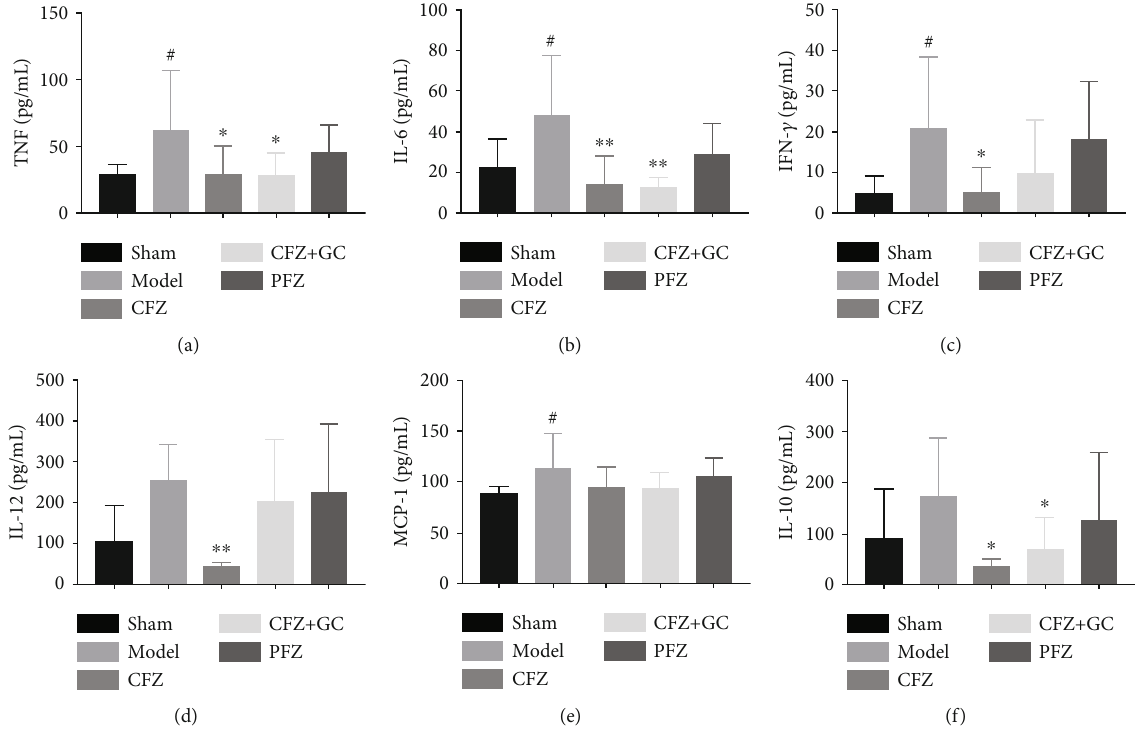
Figure 6: In fl ammation and chemokine levels in mice of each group: (a – f) tumor necrosis factor- (TNF-) α , interleukin- (IL-) 6, interferon- (IFN-) γ , IL-12, and monocyte chemoattractant protein- (MCP-) 1 levels, respectively. All data are presented as mean ± SD ( n ≥ 5 /group). # P < 0 : 05 and ## P < 0 : 01 versus the sham group; ∗ P < 0 : 05 and ∗∗ P < 0 : 01 versus the model